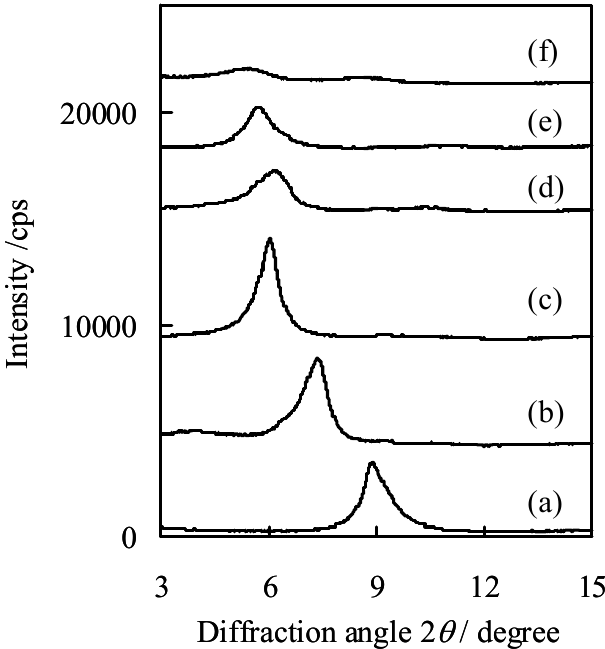
Figure 6. XRD patterns of the procatalysts and related materials. Ni 2+ -Mica after drying at 200 °C ( a ) and treated with only CH CN ( b ); L1 (c); L2 (d); L3 (e), and L4 ( f ) in CH 3 The measurement of samples ( b )–( f ) were performed after drying at 110